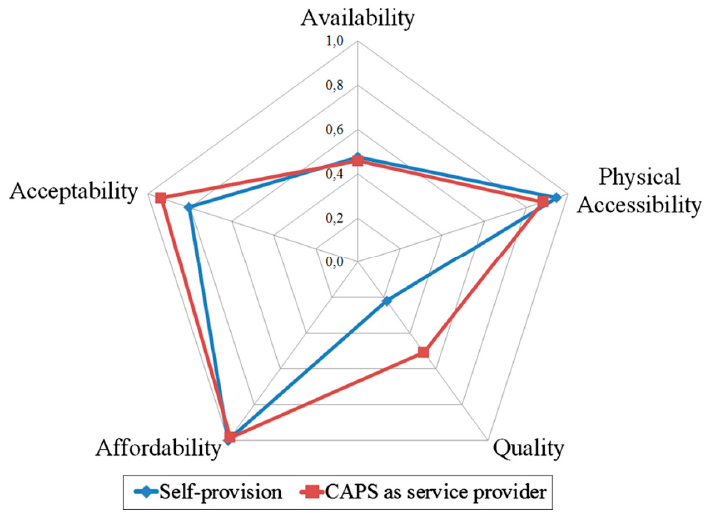
Figure 1. Comparing the extent to which water sources fulfil the normative criteria of the human right to drinking water. From Reference [28].